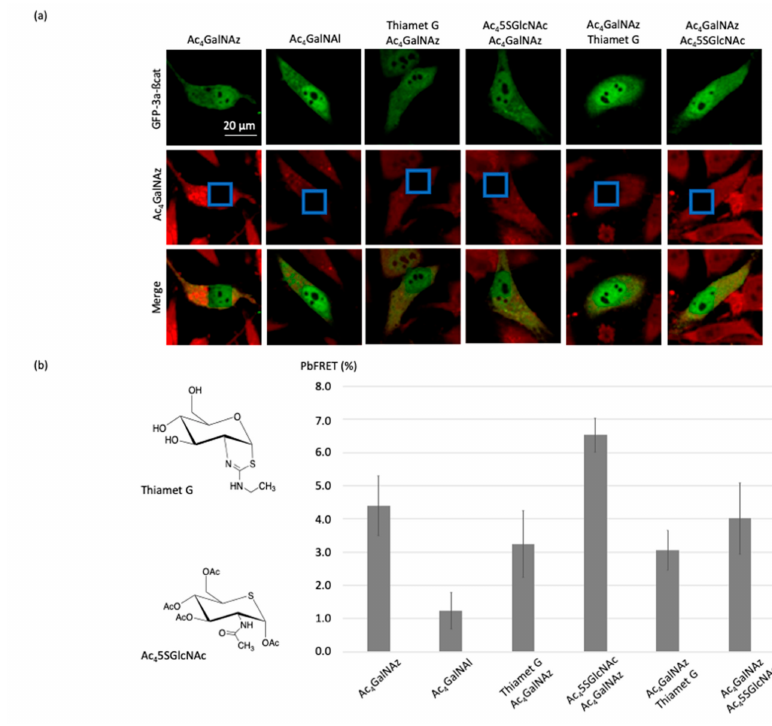
Figure 6. Imaging the changes of pb-FRET for GFP-3a- β -catenin in HeLa cells induced by the OGT and OGA inhibitors. ( a ) Fluorescence images of the O -GlcNAcylated glycoform of β -catenin before and after photobleaching using Thiamet-G or Ac 4 5SGlcNAc. ( b ) Histograms corresponding to calculated pb-FRET inside the cells after photobleaching using thiamet-G or Ac 4 5SGlcNAc, whose structures are shown at the